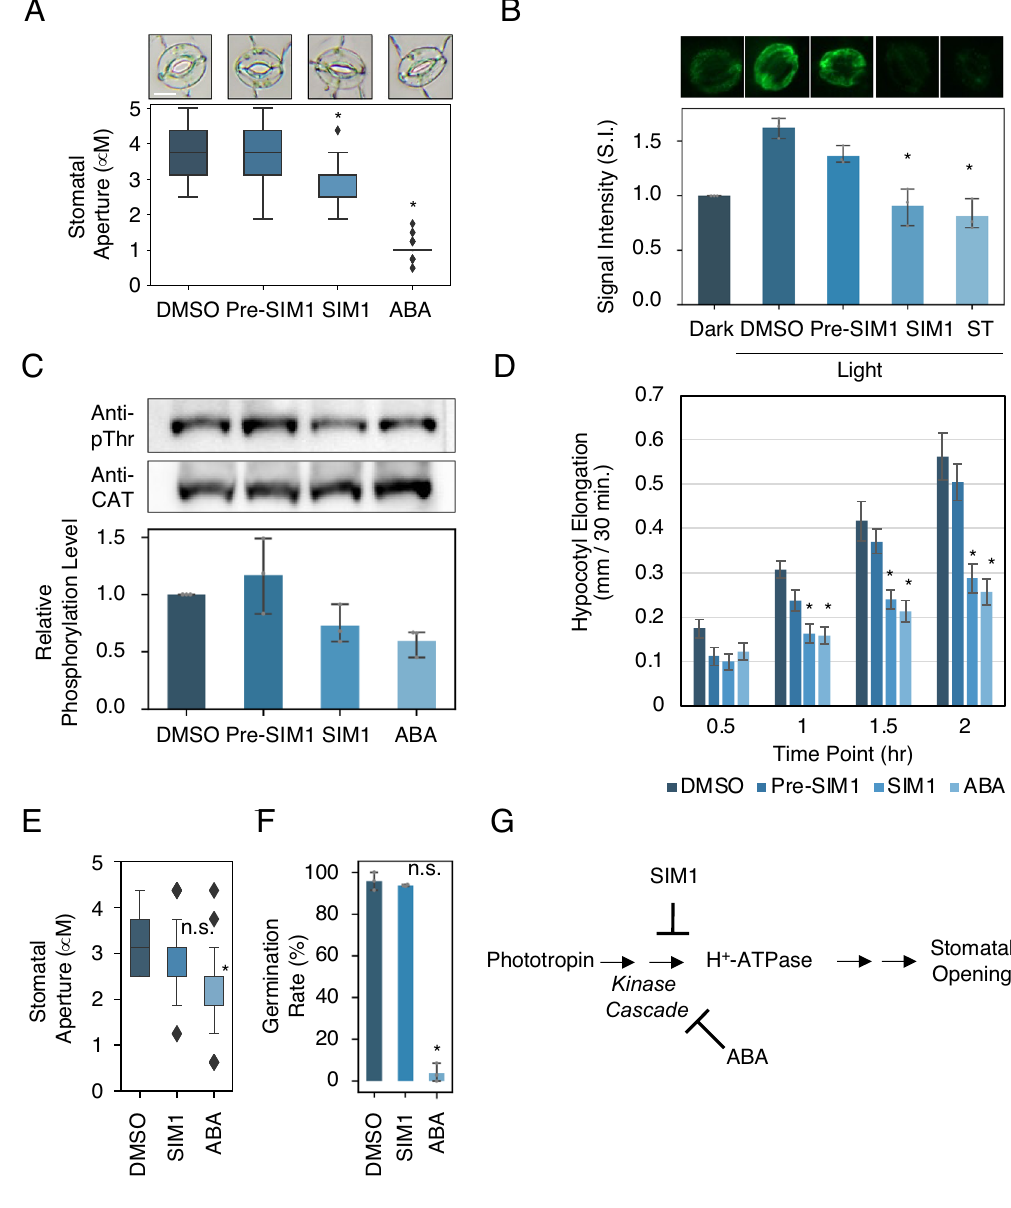
Figure 3. SIM1 inhibits promotion of H + -ATPase phosphorylation in Arabidopsis thaliana . ( A ) Inhibition of light induced stomatal opening by the treatment of SIM1 in A. thaliana . Stomatal apertures were measured after 3 h of light irradiation in the presence of the indicated compounds. Representative appearances of stomata are shown in the top row. DMSO, 0.5% Dimethyl sulfoxide, mock control; Pre-SIM1, 50 µM Non sulfonimidated form of SIM1; ABA, 10 µM Abscisic acid, positive control. Scalebar = 10 µm. Asterisk indicates statistical significance compared to DMSO treatment (student t-test p < 0.05). Diamonds indicate outliers. Means ± SD ( n > 45). If not specified, compounds were treated at the concentration of 50 µM. ( B ) Detection of phosphorylated H + -ATPase in guard cells of A. thaliana as determined by immuno-histochemical staining using the antibody raised against phosphorylated penultimate Thr (anti-pThr). Representative stained stomata are displayed in the upper row. Prior to irradiation, samples were treated with the indicated compounds for 30 min. Dark , 20 min of darkness; Light , 20 min of red light (50 μmol m −2 s −1 ) followed by 2.5 min of blue light (10 μmol m −2 s −1 ) irradiation superimposed on background red light. Light treatment increases the amount of phosphorylated H + -ATPase at 1.5-fold (Dark to Light DMSO), while SIM1 and ST (50 µM Staurosporine, the broad-spectrum kinase inhibitor as positive control) treatment suppresses such increase. Means ± SD ( n = 3; 29 < stomata per replicate). ( C ) Detection of phosphorylated H + -ATPase in Arabidopsis hypocotyl of 4 days-old seedling as determined by immunoblot using anti-pThr and anti-CAT which the latter recognizes the catalytic domain of PM H + -ATPase. Seedlings were treated with the indicated compounds for 2 h before sampling. For better visualization, blot images were cropped. See Supplementary Fig. S1 for full view. Means ± SD ( n = 3). ( D ) Quantification of hypocotyl elongation in A. thaliana under respective compound treatment. Means ± SE ( n = 4; 10 seedlings per replicate). ( E ) Promotion of stomatal closure against opened stomata in A. thaliana . First, the isolated epidermal peels were irradiated with light for 4 h in buffer, and treated with respective compounds, and further irradiated for 3 h prior to stomatal aperture quantification. Diamonds in the boxplots represent outliers. n.s., no statistically significant difference compared to DMSO treatment (student t-test p > 0.05). Means ± SD ( n = 45). ( F ) Seed germination tests using Arabidopsis seeds. Seeds were immersed in water containing respective chemicals and were incubated in dark for 5 days, and ratios of germinated seeds were calculated. Means ± SD ( n = 3, 24 to 50 seeds per replicate). ( G ) Simplified graphical abstract of the mode of action of SIM1 along with that of ABA in stomatal opening signaling. phototropin, a blue-light receptor kinase that triggers stomatal opening 7